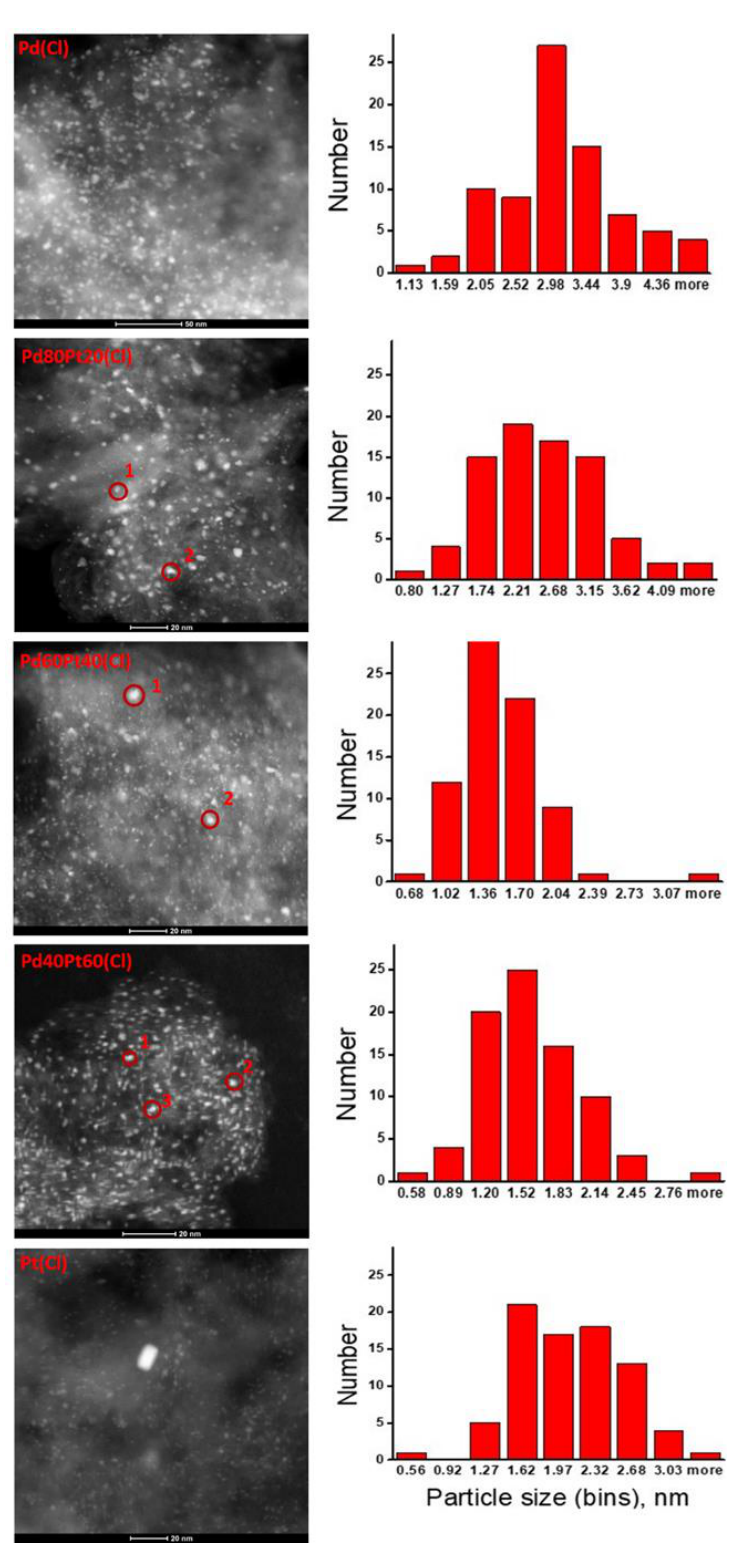
/ C catalysts. EDS areas: for Pd 80 Pt 20